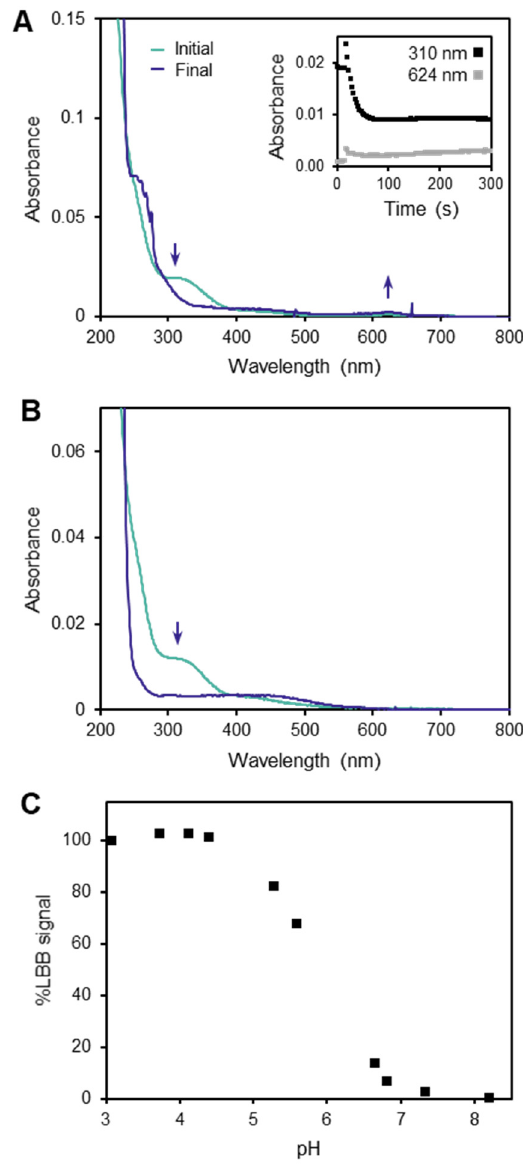
Figure 2. Mn(III)–DFOB is incompatible with the LBB method, due to its rapid decomposition at low pH, a methodological requirement for the LBB assay. ( A ) LBB solution added to 6 µ M Mn(III)–DFOB solution. The characteristic Mn(III)–DFOB band at 310 nm disappeared on a timescale of seconds, and the oxidized LBB band at 624 nm did not appear. ( B ) One percent acetic acid without LBB added to 6 µ M Mn(III)–DFOB solution. The Mn(III)–DFOB band still disappeared, indicating that the Mn(III)–DFOB decomposition was caused by the change in pH rather than any reaction with LBB. ( C ) LBB signal with KMnO 4 drops off in reaction solutions above pH 5, demonstrating that a low pH reaction solution is required for this method. Percent LBB signal reports the absorbance at 624 nm relative to the reaction at pH 3, the baseline solution pH for this method.